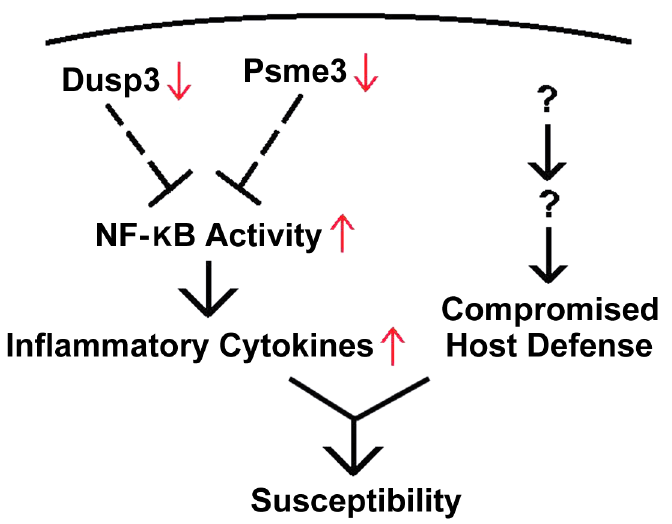
Figure 7. Down-regulation of Dusp3 and Psme3 in A/J is associated with over-production of pro-inflammatory cytokines. Both Dusp3 and Psme3 inhibit NF- k B activity, which is responsible for the production of inflammatory cytokines. The reduced expression of Dusp3 and Psme3 in A/J mice is associated with elevated NF- k B activity, which leads to increased inflammatory cytokines. Dusp3 and Psme3 , together with other factors from murine chromosome 8 and 18, contribute to S. aureus susceptibility of A/J